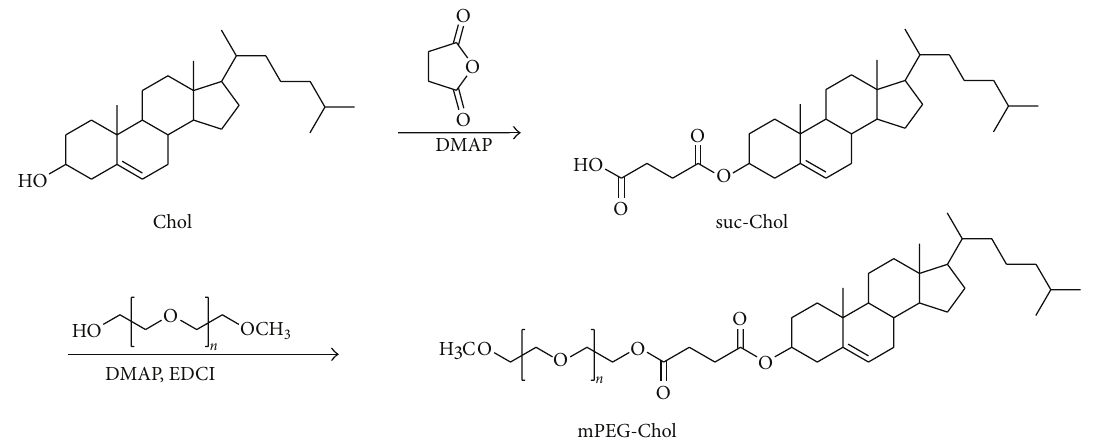
Scheme 1: Synthetic route of mPEG-Chol